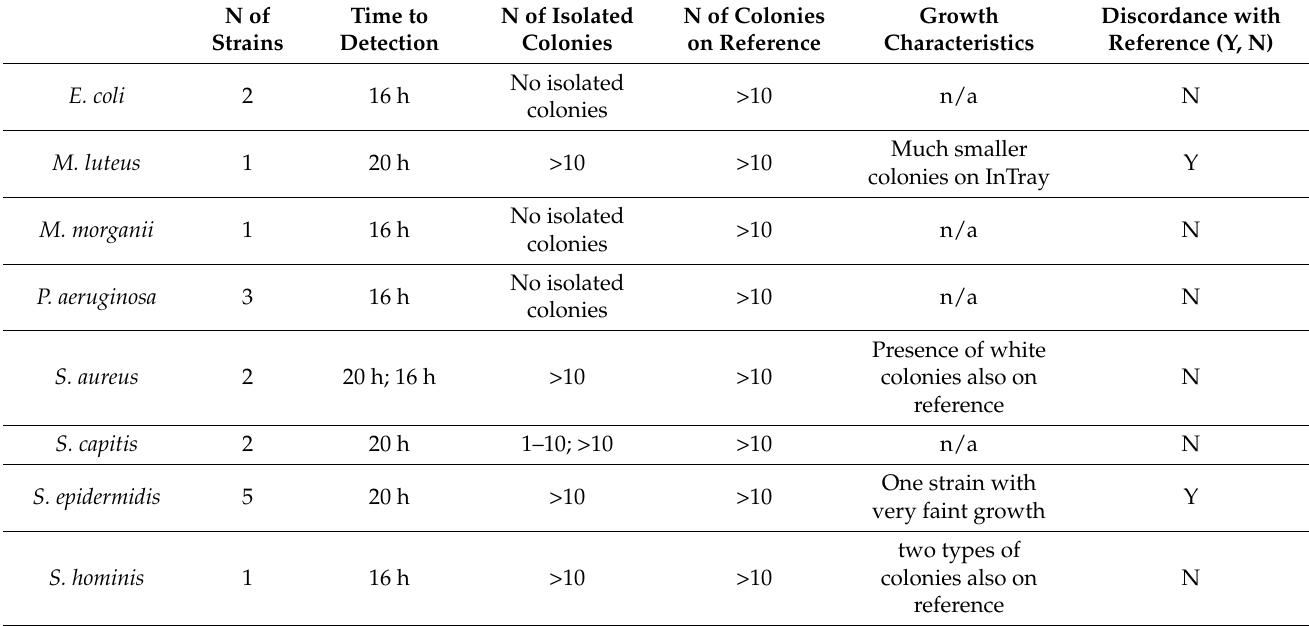
Table 5. Table of discrepancies of growth on InTray MH chocolate with reference media, including the number of isolated colonies. n/a = information not available.